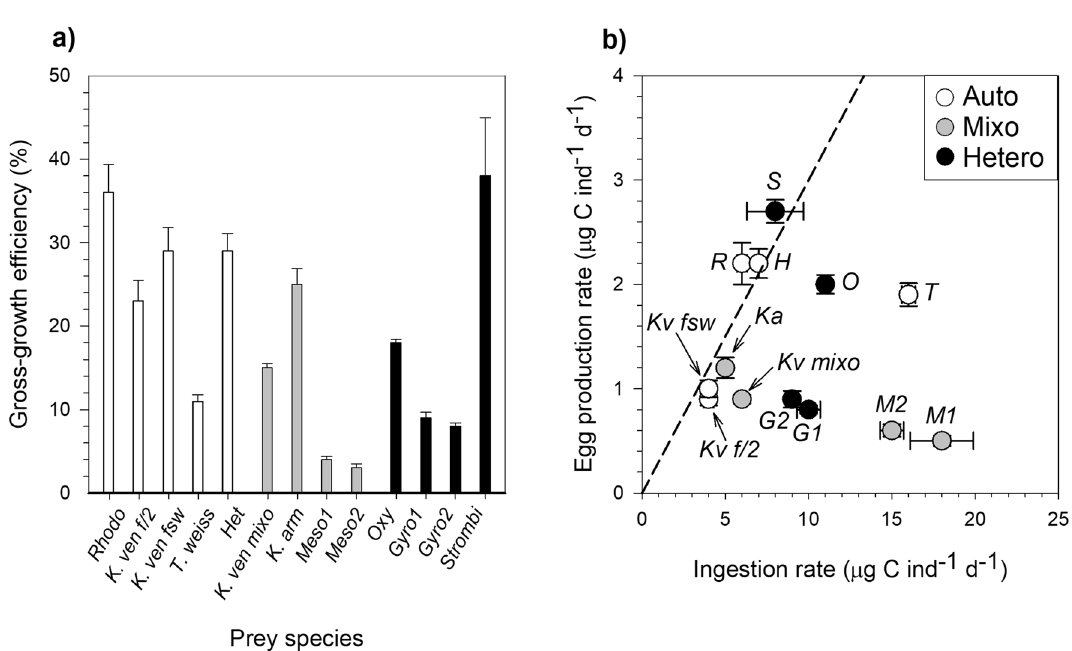
Figure 5. Gross-growth efficiency of P. grani . ( a ) Carbon gross-growth efficiency in the different dietary conditions and ( b ) egg production rate as a function of ingestion rate. The dashed line in ( b ) represents a 30% gross-growth efficiency illustrated for comparative purposes. Abbreviations are described in Table 3. Error bars are ± 1